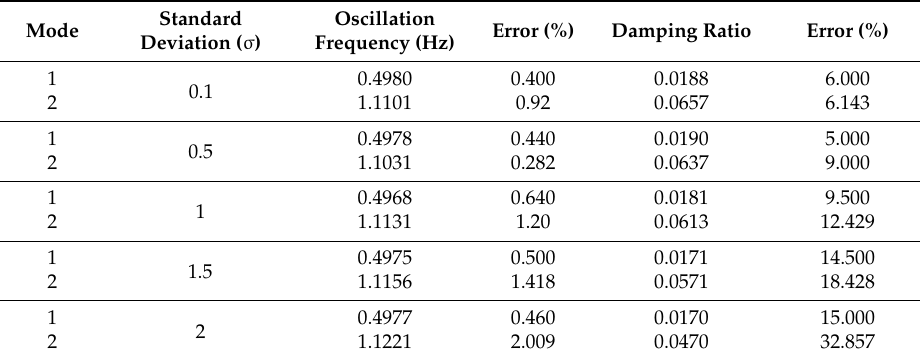
Figure 10. Full band time-frequency distribution and Fine analysis of frequency slice based on FSWT. ( a ) FSWT 2D map ( σ = 0.5); ( b ) Reconstructed signal of [0, 0.8] Hz; ( c ) FSWT 2D map ( σ = 1); ( d ) Reconstructed signal of [0, 0.8] Hz; ( e ) FSWT 2D map ( σ = 1.5); ( f ) Reconstructed signal of [0, 0.8] Hz; ( g ) FSWT 2D map ( σ = 2); ( h ) Reconstructed signal of [0, 0.8] Hz. Table 3. Result of identification with white